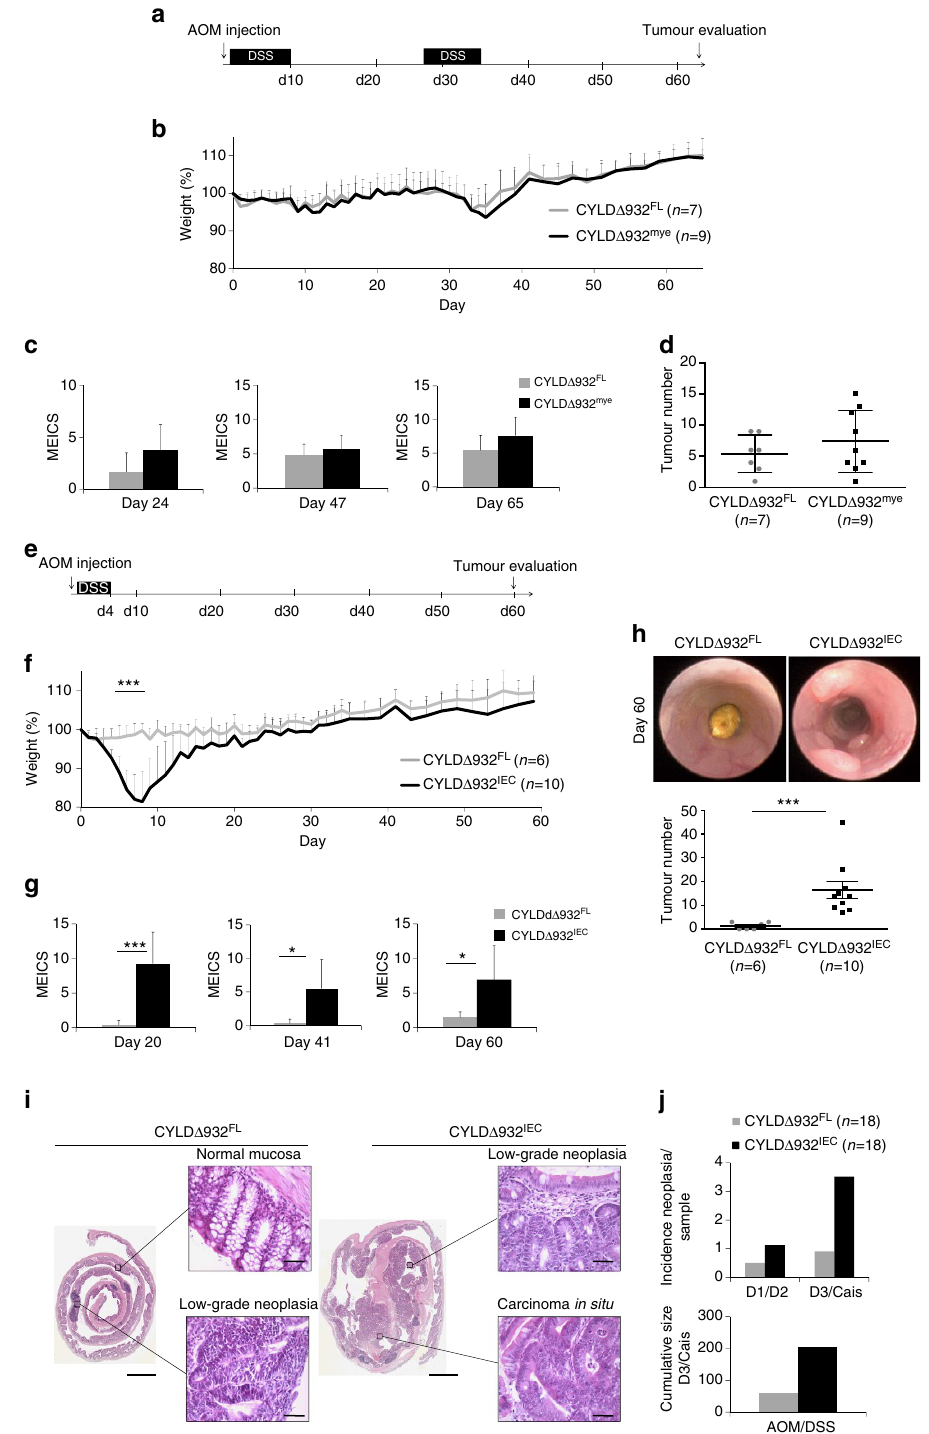
Figure 1 | Epithelial CYLD suppresses AOM/DSS-induced colon tumorigenesis. ( a ) CYLD D 932 mye and CYLD D 932 FL male littermates were injected with 10mgkg (cid:2) 1 AOM followed by two cycles of treatment with 2% DSS. ( b ) Graph showing body weight. ( c ) Quantification of murine endoscopic index of colitis severity (MEICS) on the indicated days. ( d ) Graph showing colon tumour numbers on day 65. One representative out of two independent experiments is shown. ( e ) CYLD D 932 IEC and CYLD D 932 FL male littermates were injected with 7.5mgkg (cid:2) 1 AOM followed by one cycle of treatment with 2% DSS. ( f ) Graph showing body weight. ( g ) MEICS on the indicated days. ( h ) Representative endoscopy images and graph showing colon tumour numbers. One representative out of five independent experiments is shown. ( i ) Representative Hematoxylin and Eosin (H&E) stained distal colon sections on day 60 from the indicated AOM/DSS-treated mice. Scale bars, 2,500 and 50 m m. ( j ) Graphs showing the incidence of low-grade intraepithelial neoplasia (D1/D2) and high-grade intraepithelial neoplasia/carcinoma in situ (D3/Cais), and the cumulative size of high-grade intraepithelial neoplasia/ carcinoma in situ D3/(Cais) in the indicated AOM/DSS-exposed mouse lines. The evaluated samples comprise specimens from experiments shown in Fig. 1e–h and Supplementary Fig. 2a–d. For all experiments, data are shown as mean ± s.d. Statistical significance was determined with Student’s t -test; * P r 0.05, *** P r